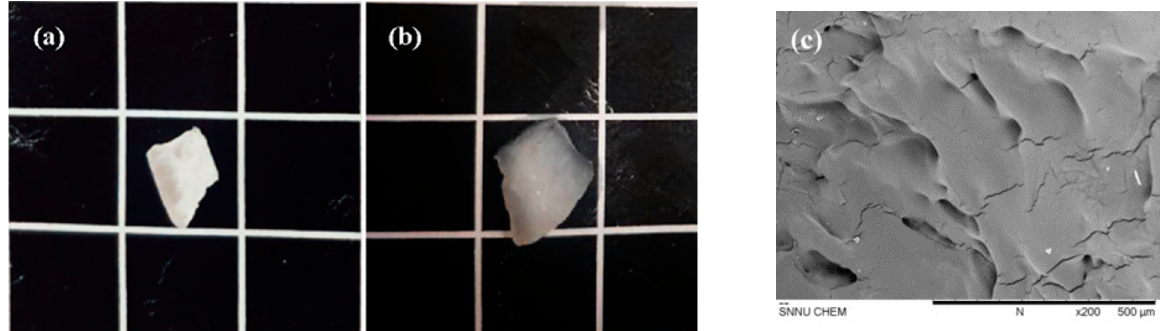
Figure 11. The physical image of gel2 hydrogel at dry state ( a ), fully swollen at 25 ◦ C ( b ), the scanning electron microscope image of the fully swollen hydrogel at 25 ◦ C ( c ).